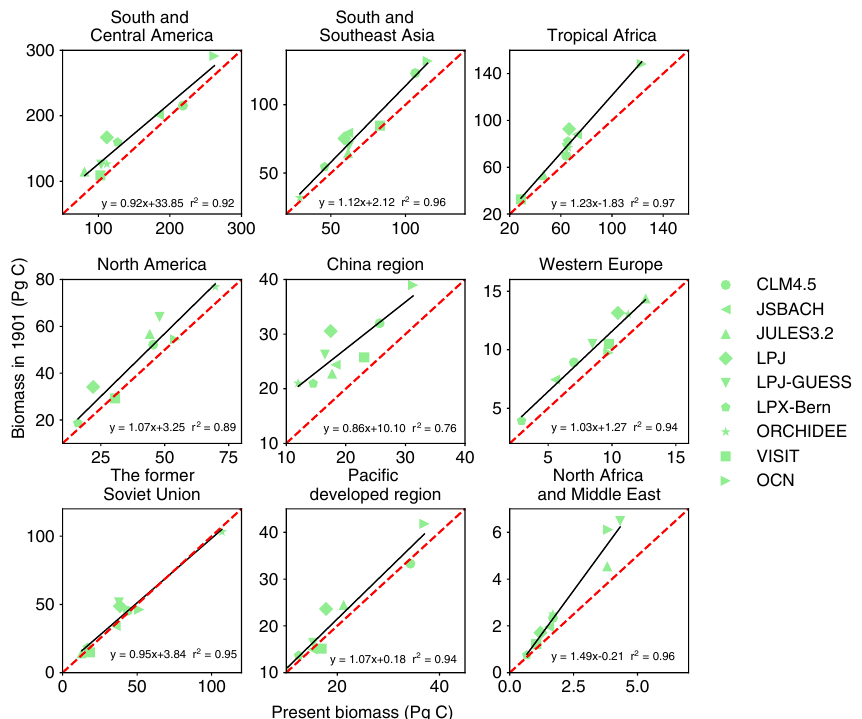
Figure 4. The relationship between initial biomass in 1901 and present biomass (average of biomass from 2000 to 2012) across the TRENDY- v2 models for each region. Note that both biomass in 1901 and present biomass are from TRENDY models, not the observations. Dashed line is the 1 : 1